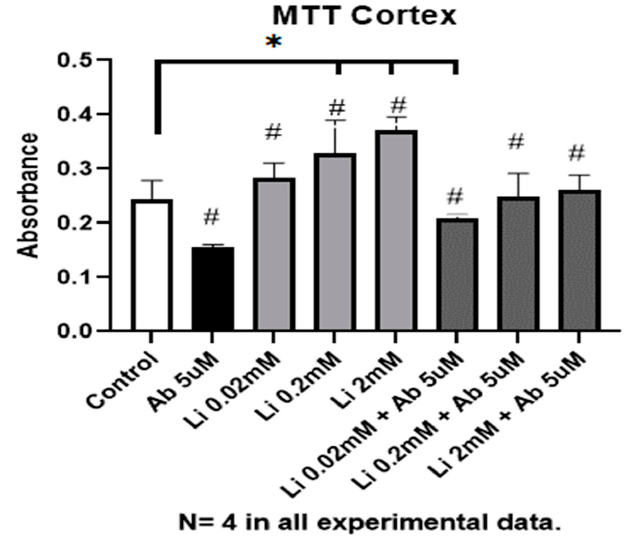
Figure 1. Graph representative of MTT [(3-(4,5-dimethylthiazol-2-yl)-2,5-diphenyltetrazolium bro- mide] absorbance in primary cultures of rat cortical neurons treated with different concentrations of lithium (0.02 mM; 0.2 mM and 2 mM) and neurons co-treated with lithium chloride and 5 μ M A β 1-42 . The experimental controls are depicted in the leftmost (white) bar, indicative of untreated neurons, and the black bar represents the positive control for A β 1-42 toxicity. Light gray bars indicate the effect of lithium treatment alone on MTT uptake, as compared to untreated controls. Dark gray bars refer to the effect of lithium on neurons pre-treated with lithium and challenged with fibrillary A β 1-42 (independent samples t -tests * p < 0.05 vs. control, # p = 0.05 vs. A β 1-42 ). The raw data are described in Table A1.